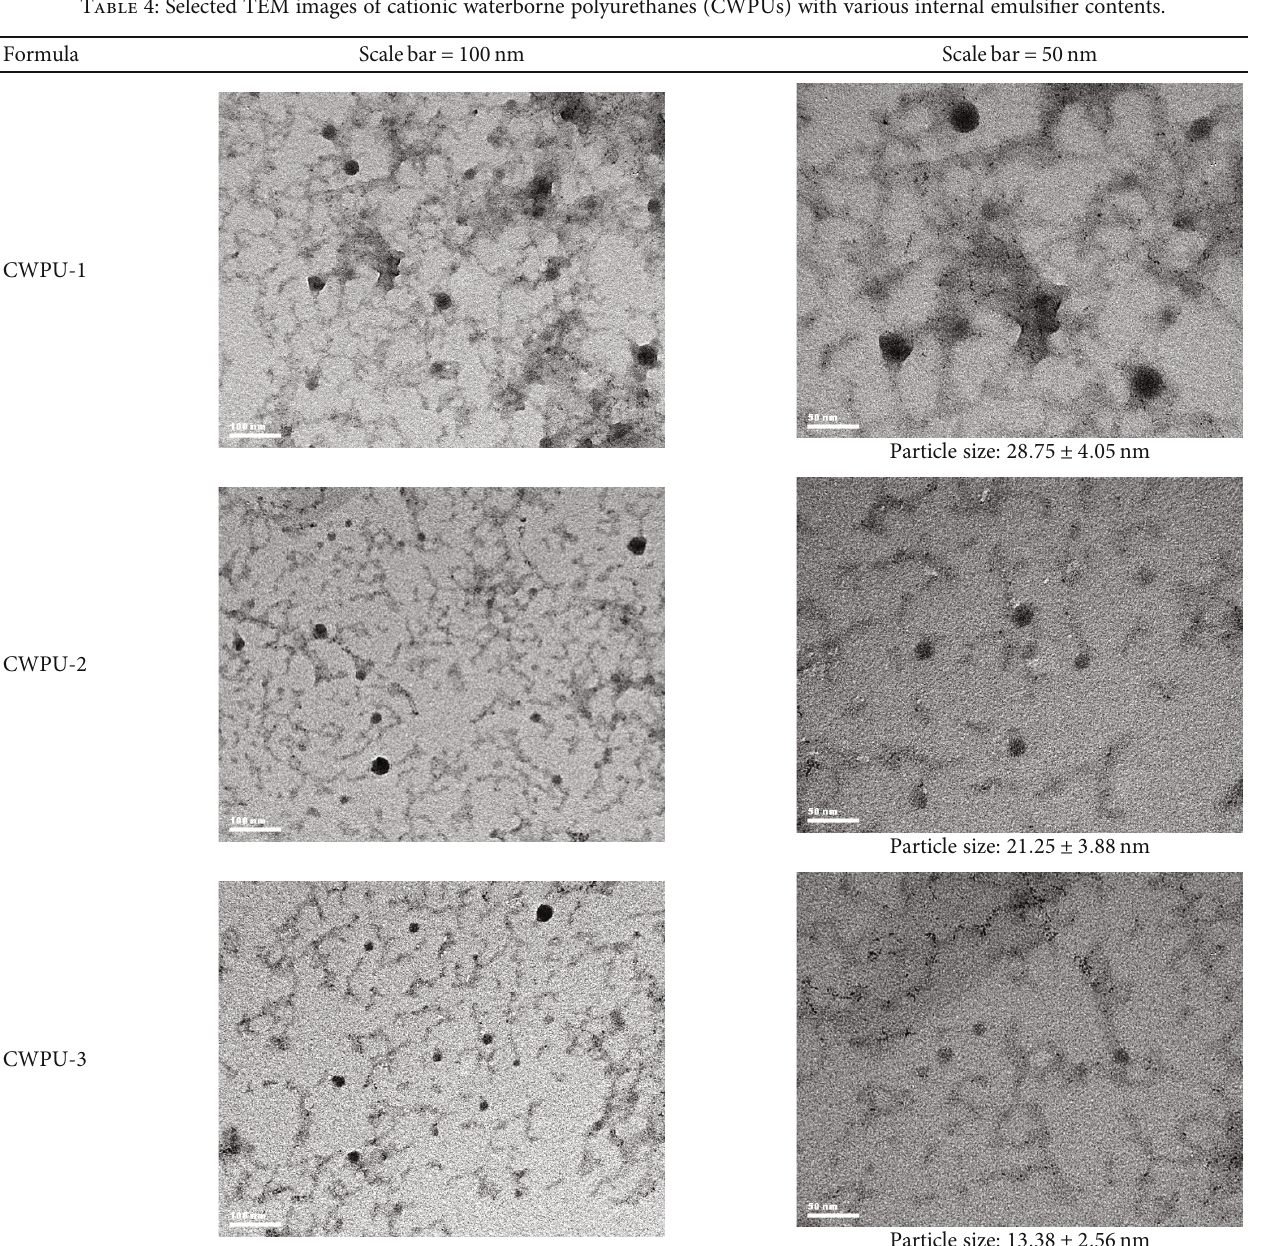
Table 4: Selected TEM images of cationic waterborne polyurethanes (CWPUs) with various internal emulsi fi er